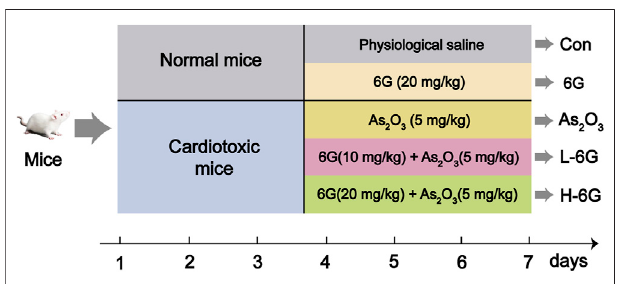
FIGURE 2 | Diagram of animal experimental